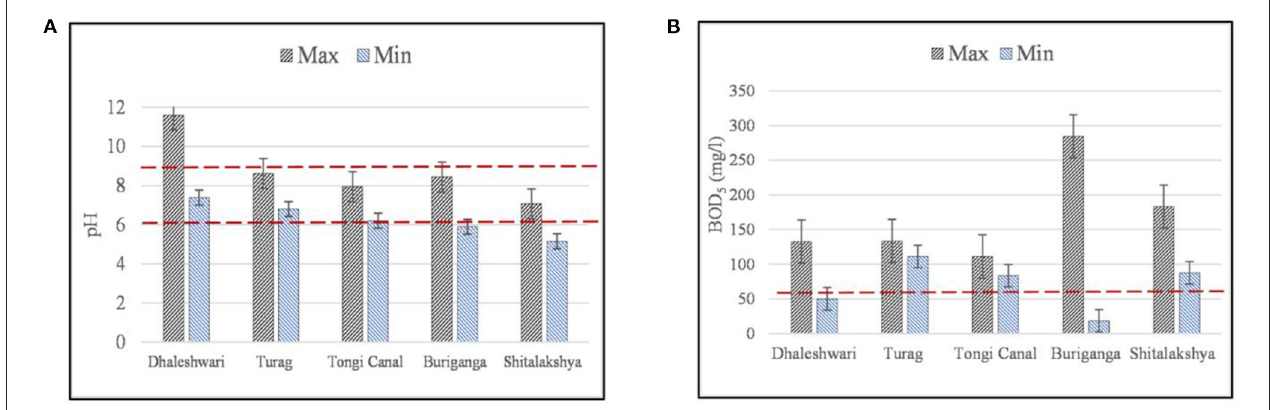
FIGURE 2 | (A,B) Maximum and minimum concentrations of pH and BOD 5 for the selected outfalls along the peripheral rivers of Dhaka (error bars indicate standard error of mean and red dotted lines indicate the Bangladesh standards of water quality according to ECR’97).